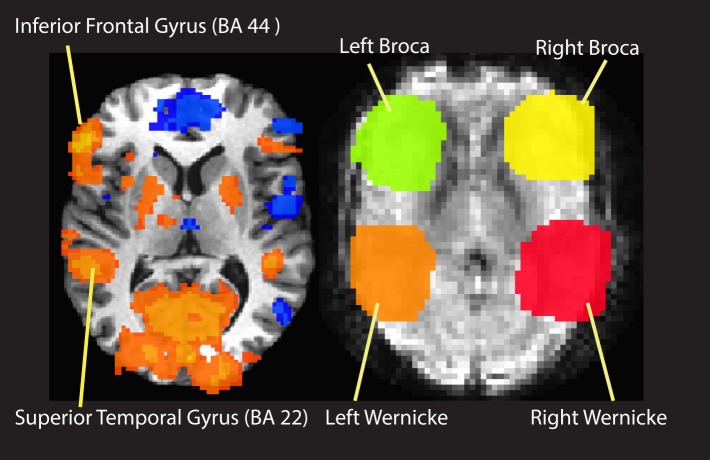
An example of ROI definition for calculation of laterality index.